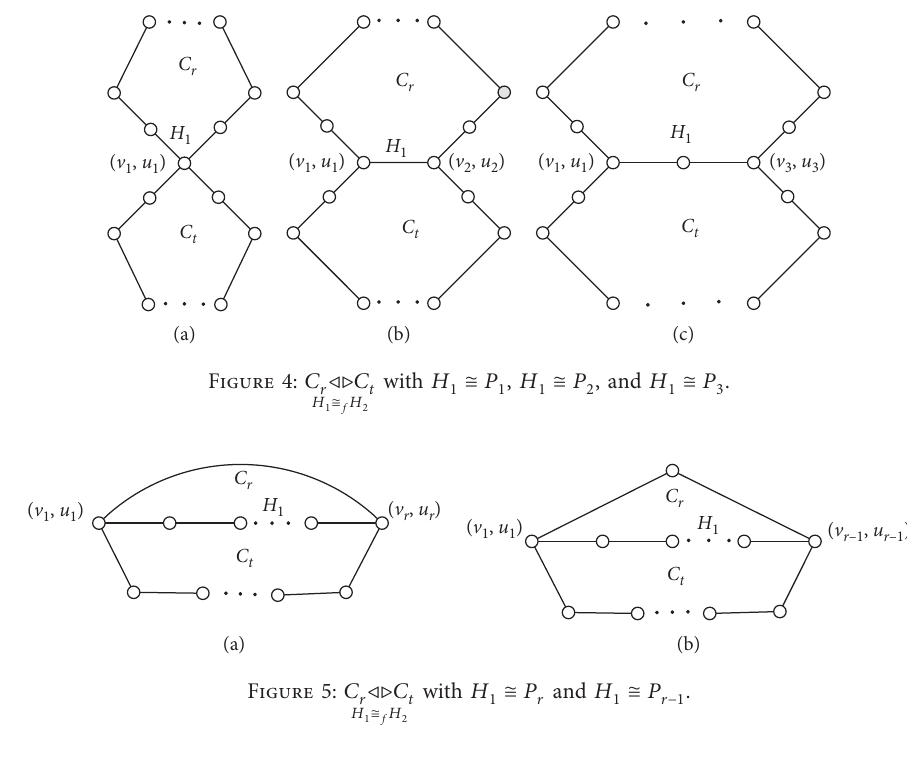
C with H r ⊲⊳ t H 1 � f H 2